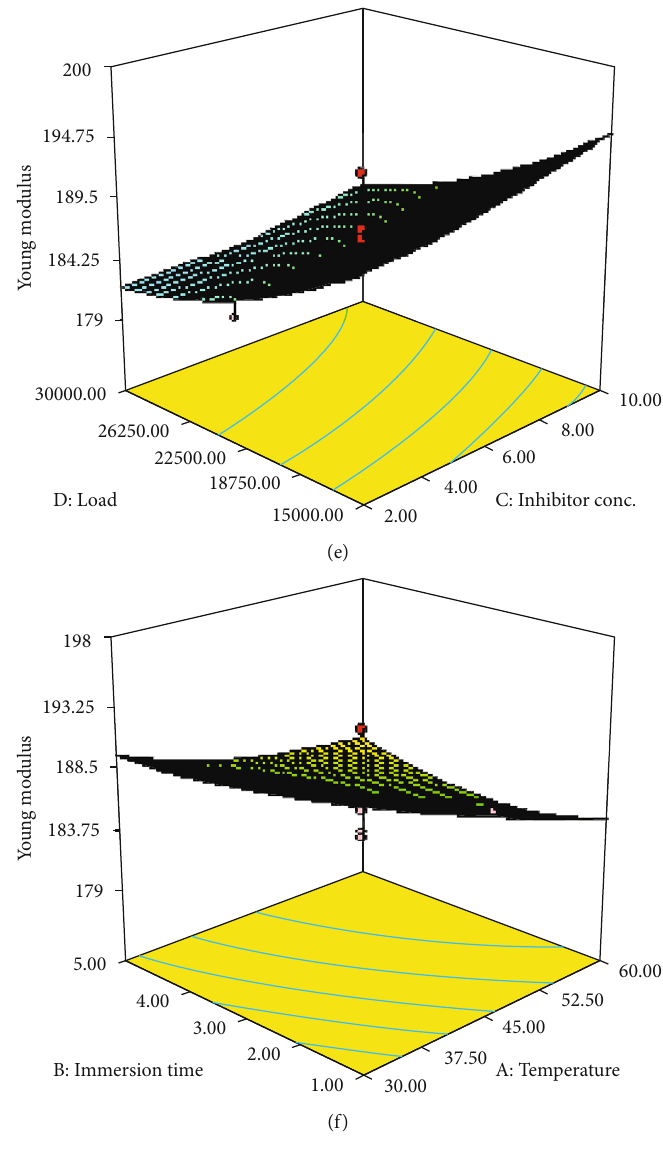
Figure 8: 3D response surface plot showing (a) inhibitor concentration and temperature, (b) load and temperature, (c) inhibitor concentration and immersion time, (d) load and immersion time, (e) load and inhibitor concentration, and (f) immersion time and temperature in fl uence on Young